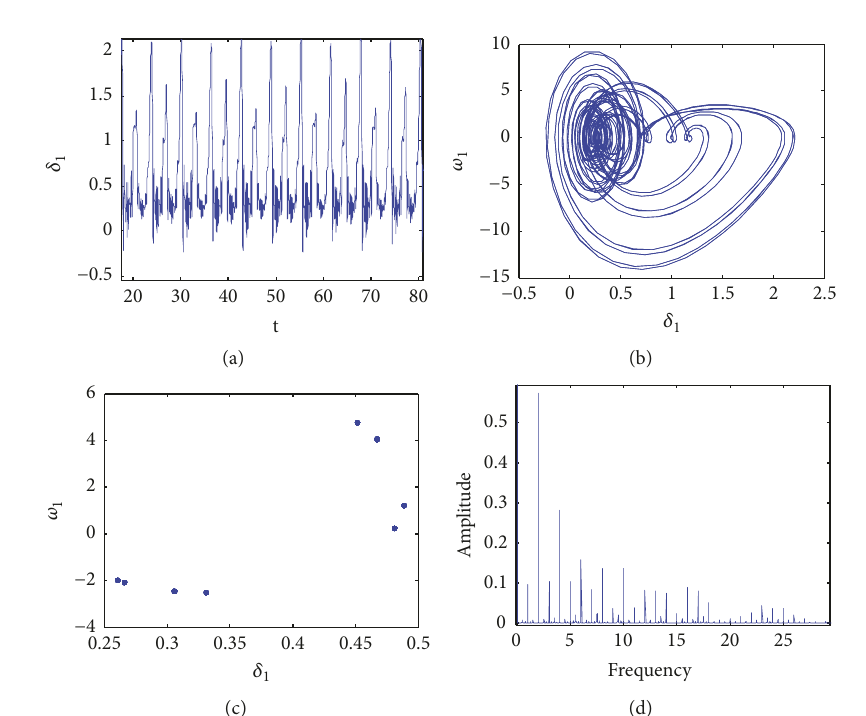
Figure 11: Period 8 motion ( D =0.00835). (a) Time history. (b) Phase portrait. (c) Poincar´e map. (d) Frequency